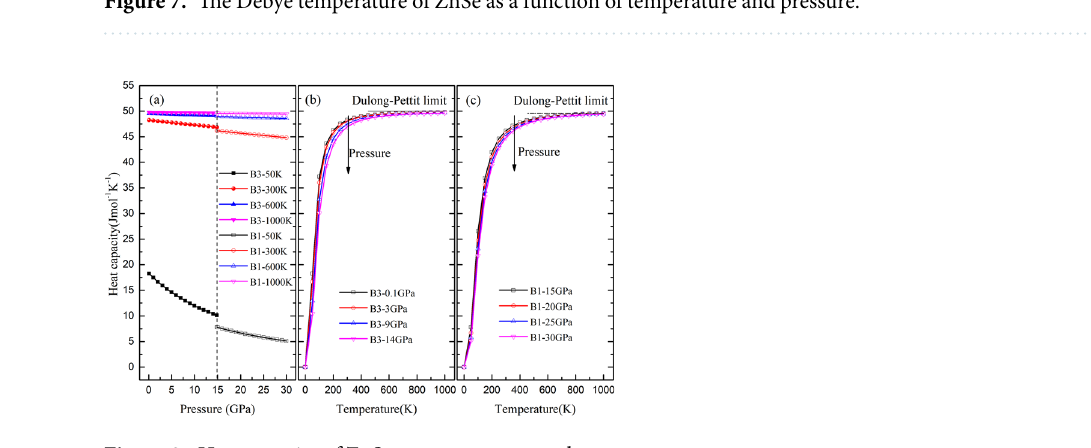
Figure 7. The Debye temperature of ZnSe as a function of temperature and pressure.